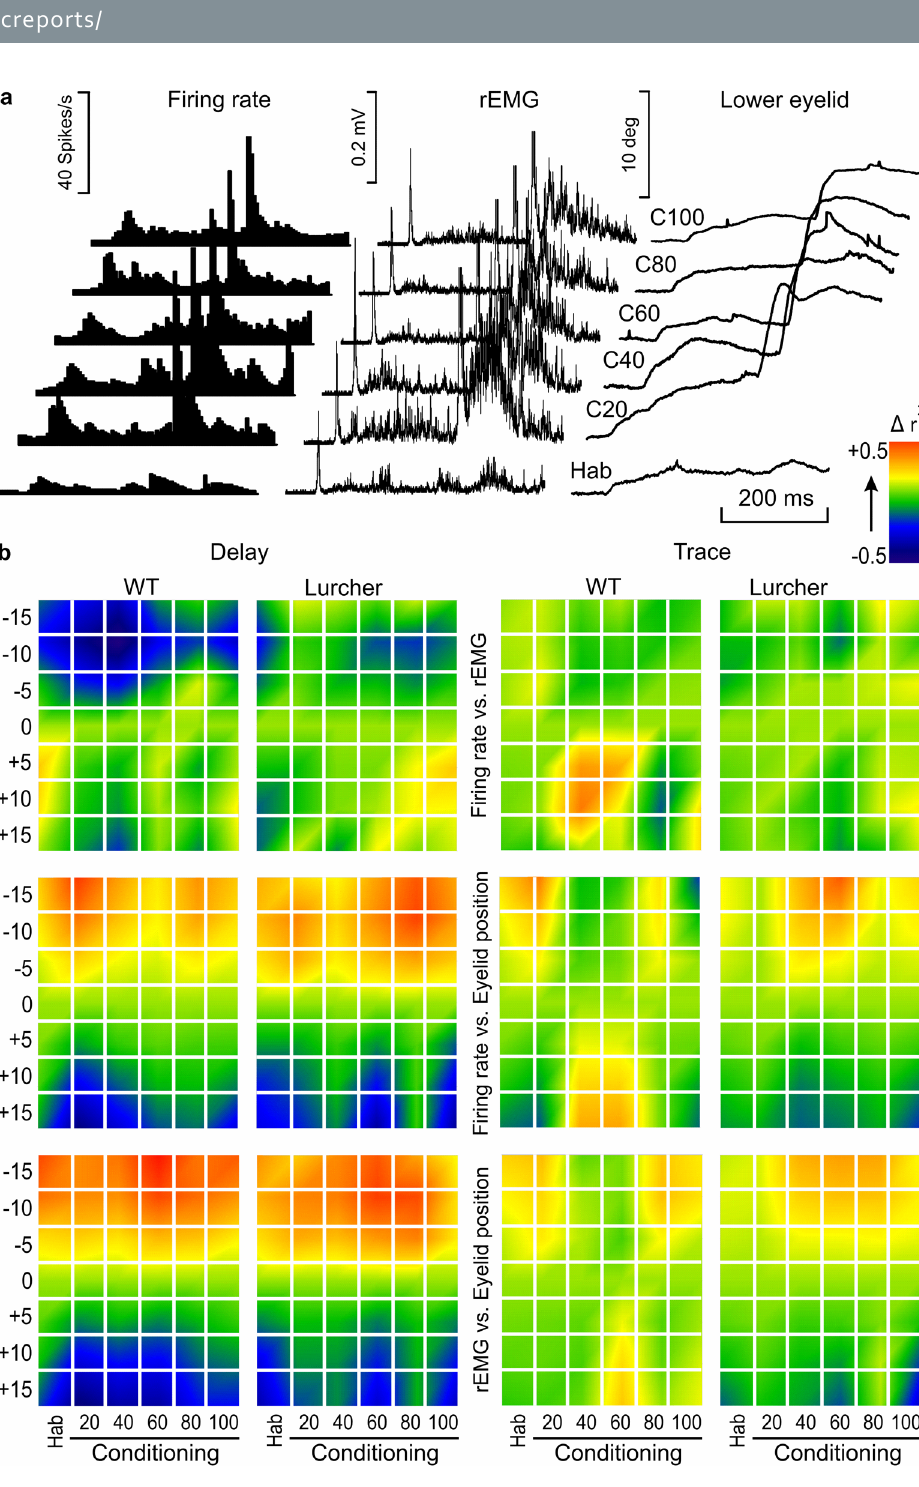
Figure 6. Timing between firing rate, rEMG, and lower-eyelid position during classical eyeblink conditioning using delay and trace paradigms in WT and Lurcher mice. ( a ) A raster representation of firing rate, rEMG, and lower-eyelid position corresponding to the average of 20 habituation (Hab) and 100 conditioning ( c ) trials collected during a single conditioning session. Conditioning trials were averaged in groups of 20. Represented data correspond to a WT mouse conditioned with a delay paradigm. ( b ) Colorimetric representation of the timing correlation between firing rate vs. rEMG (top), firing rate vs. eyelid position (middle), and rEMG vs. eyelid position (bottom) during a single conditioning session from WT and Lurcher mice. r 2 values were computed between the first and the second set of records, the latter being shifted − 15 ms, − 10 ms, − 5 ms, + 5 ms, + 10 ms, and + 15 ms from the original (0 ms) timing. A comparison was carried out between regions in the CS-(US − 20 ms) interval, each one delimited by turning points automatically detected on the first recording. Normalized r 2 values are represented by colored squares corresponding to each shifted time against each average of training (Hab, Conditioning) trials, mice (WT, Lurcher) types, and conditioning (Delay,